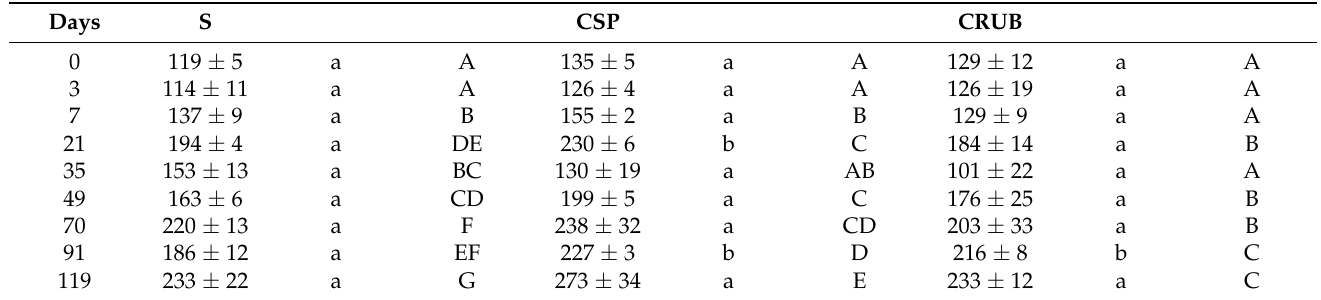
Capital letters indicate significant differences among sampling dates and small letters among treatments ( p < 0.05). S: soil control, CSP: poultry manure and wheat straw; CRUB: biosolids and wood shavings. Values ± represent standard deviations of the mean